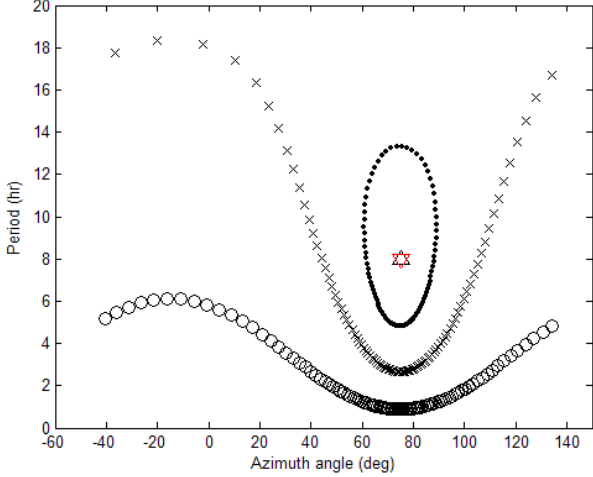
Fig.3 Plot of period vs. azimuth angle resulted from hodograph analysis of equations (8a,8b, 8c); at Fig. 3. Plot of period vs. azimuth angle resulted from hodograph 20 each time step of three cases and the original waves. Open c ircle represents the results from the 10 analysis of Eqs. (8a), (8b), (8c) at each time step of three cases and case with 0.8 α = in equations (8a,8b, 8c); Cross represents the results from the case with the original waves. An open circle represents the results from the case with α = 0 . 8 in Eqs. (8a), (8b), (8c); a cross represents the re- 0.5 α = ; and dot represents the results from the case with 0.25 α = . B lack upward pointing sults from the case with α = 0 . 5; and a dot represents the results triangle represents original wave with downward phase velocity (first wave in Table 1a) and from the case with α = 0 . 25. A black upward pointing triangle rep- red downward pointing triangle represents the original wave with upward phase velocity resents original wave with downward phase velocity (first wave in (second wave in Table 1a). 15 Table 1a) and a red downward pointing triangle represents the orig- inal wave with upward phase velocity (second wave in Table 1a).